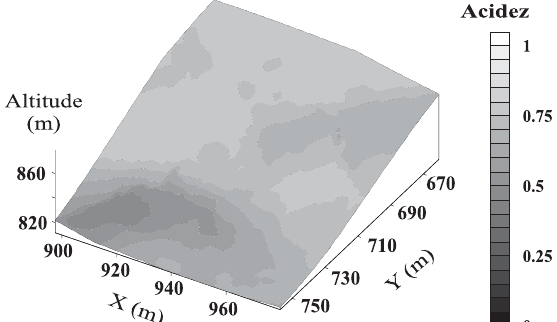
Figura 6. Mapa da ponderação da acidez do solo, com base nos atributos